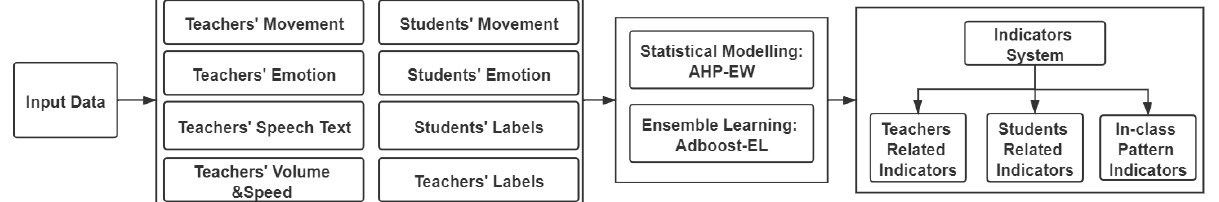
Figure 1. The framework of our in-class evaluation model.